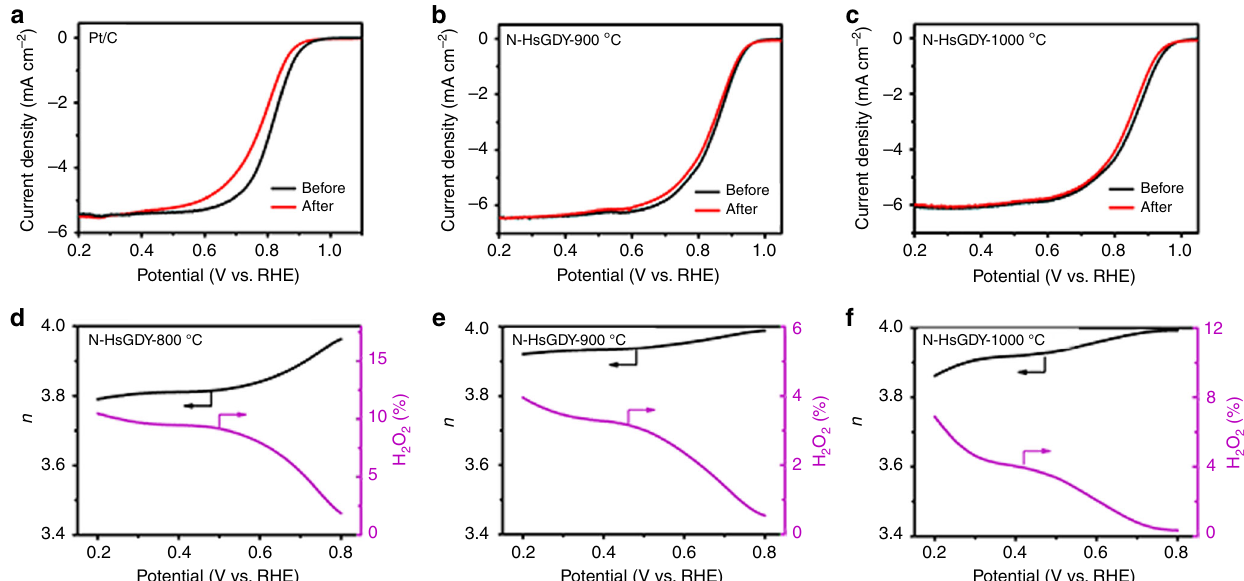
Fig. 5 Stability and electron transfer number of catalysts for oxygen reduction in basic media. a – c Durability tests of the commercial carbon-based platinum catalyst (Pt/C) ( a ), pyridinic nitrogen-doped hydrogen-substituted graphdiyne (N-HsGDY) treated at 900 °C (N-HsGDY-900 °C) ( b ), and N-HsGDY treated at 1000 °C (N-HsGDY-1000 °C) ( c ) catalysts before and after 5000 cycles in O 2 -saturated 0.1 M KOH. d – f Electron transfer numbers and peroxide yields calculated from the rotating ring-disk electrode (RRDE) measurements for N-HsGDY treated at 800 °C (N-HsGDY-800 °C) ( d ), N- HsGDY-900 °C ( e ), and N-HsGDY-1000 °C ( f